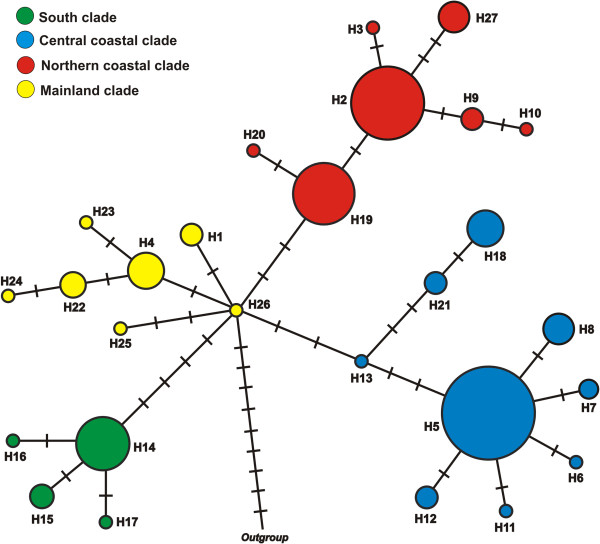
Haplotypes network. Evolutionary relationships among haplotypes of Calibrachoa heterophylla cpDNA using Median-joining network approach. Colors identified the haplogroups. Circle sizes are proportional to haplotype frequency and crossed lines are substitutions inferred in the branches.